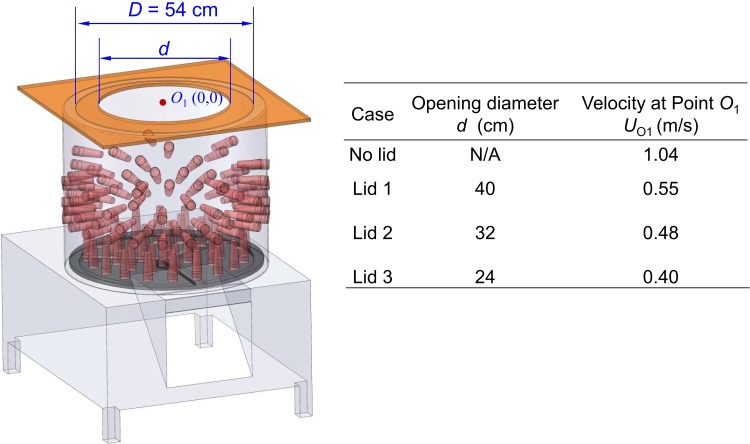
Measured velocity at the lid centre with different opening diameters.